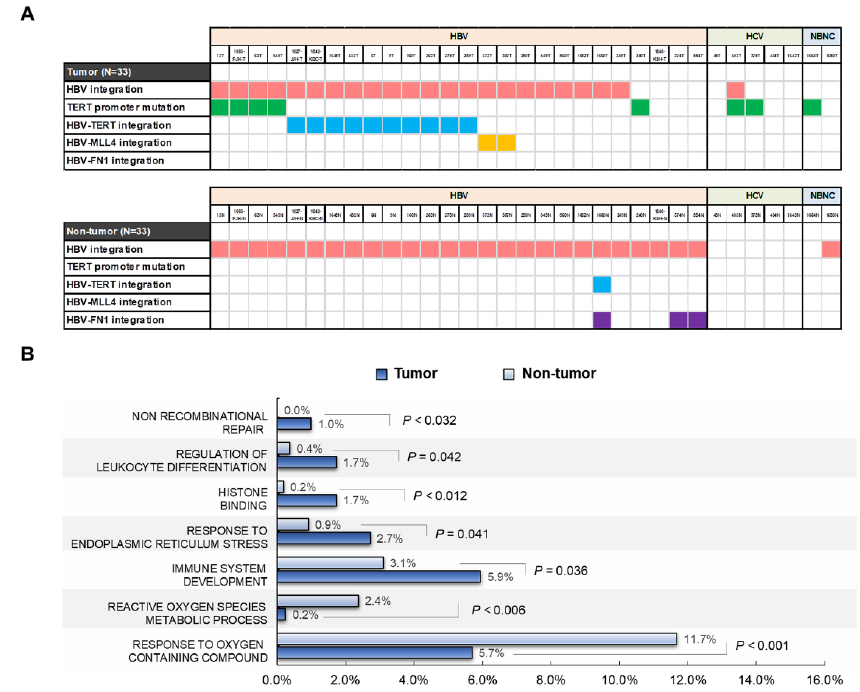
Figure 4. ( A ) Schematic view of overall HBV integrations, 124 C > T mutations in the TERT promoter, HBV- TERT , HBV- MLL4 , and HBV- FN1 integrations in the paired HCC (upper panel) and non-HCC tissues (lower panel). ( B ) Functional enrichment analysis of genes affected by HBV integration in tumors versus non-tumor tissues.